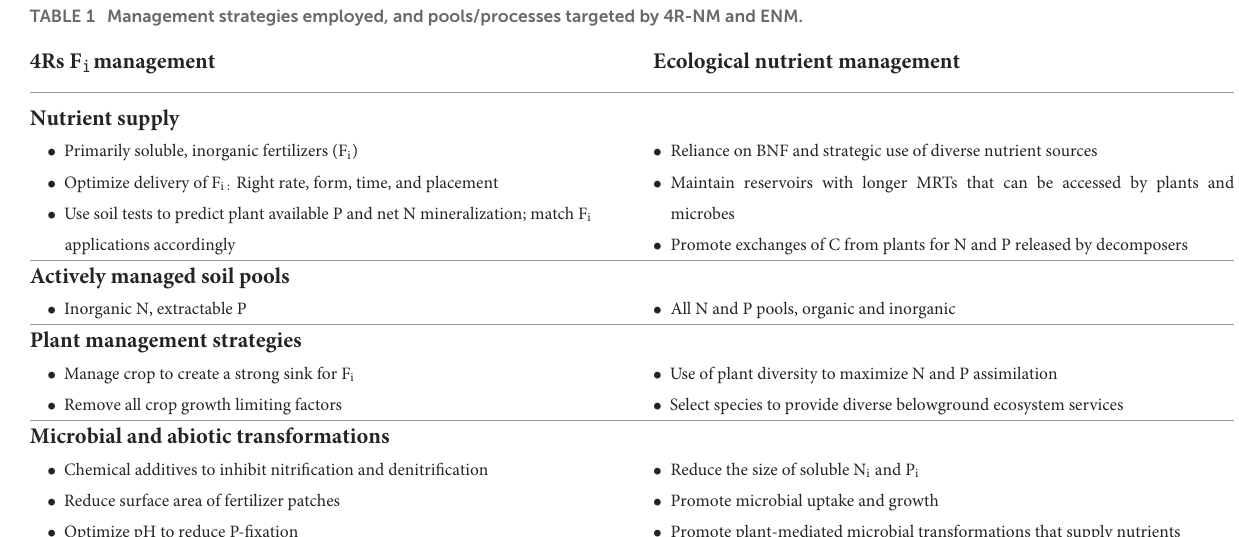
TABLE 1 Management strategies employed, and pools/processes targeted by 4R-NM and